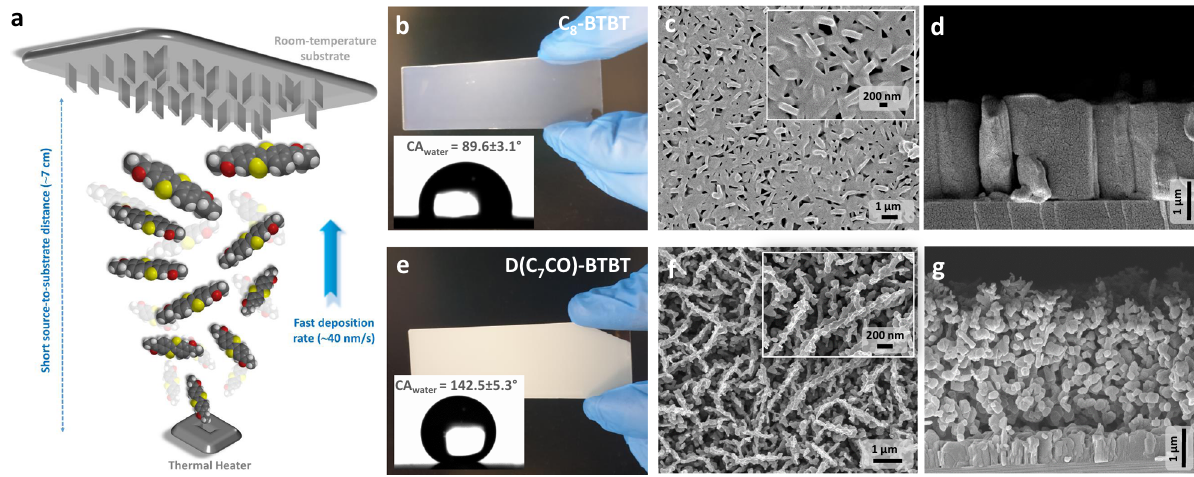
Fig. 2 Fabrication and characterization of D(C 7 CO)-BTBT and C 8 -BTBT fi lms. a Schematic illustration of the physical vapor deposition (PVD) method and the key deposition parameters used for the fabrication of nanostructured SERS fi lms. Photos ( b and e ) of the nanostructured fi lms and a water droplet on them, water contact angles (CA water ), top-view and cross-sectional SEM images of the nanostructured fi lms for C 8 -BTBT ( c and d ) and D(C 7 CO)-BTBT ( f and g ). Scale bars are shown separately for each SEM